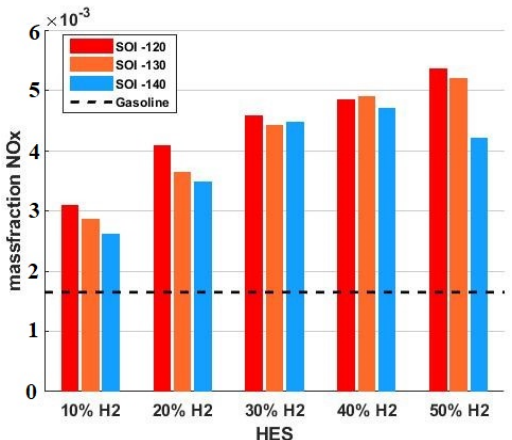
Figure 10. Influences of hydrogen direct-injection timing and HES on NO X emissions.